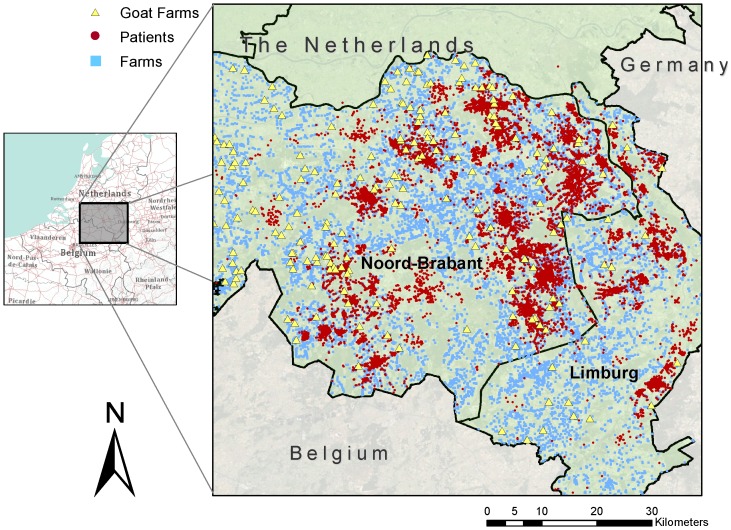
Study area: the eastern part of the province of Noord-Brabant and the northern part of the province of Limburg.Dots represent residential addresses of 92,548 study subjects. Squares represent farms holding a licence to keep livestock. Triangles represent goat farms.